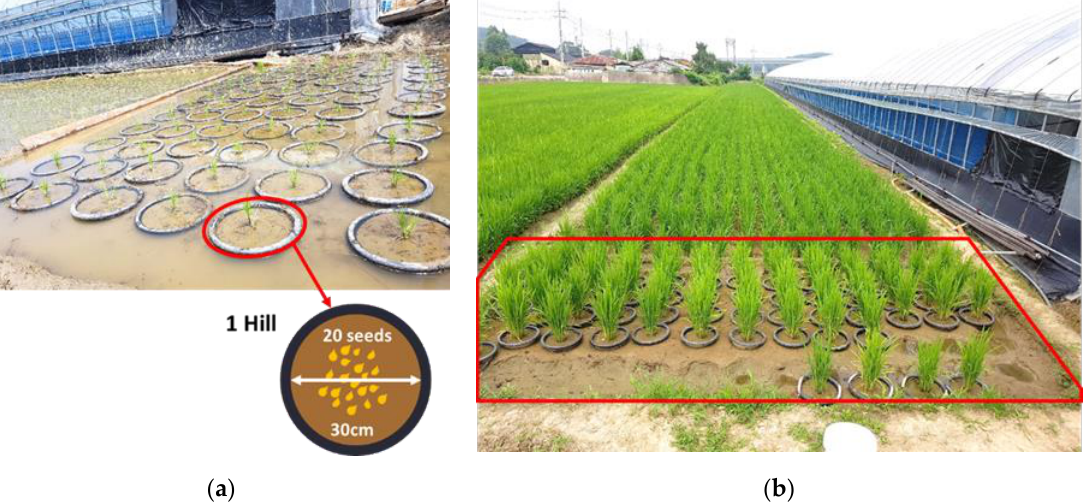
Figure 1. Experimental paddy field and rice plot description image captured at ( a ) 4 days after planting (DAP) and ( b ) 45 days after planting. The experimental paddy field is marked with a red box.